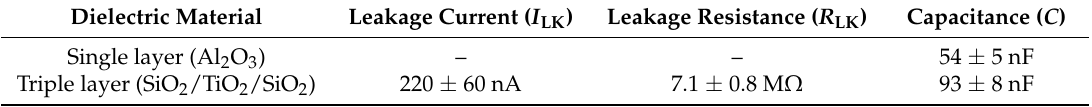
Figure 10 Intensity ( I ) decays in charge cycle for single dielectric layer ( a ) and triple dielectric layer ( b ) capacitors as a function of time ( t ). Its fittings to Equation (5) are also shown. Table 7. Mean results obtained by applying Equation (5) to the charge cycle intensity decays.